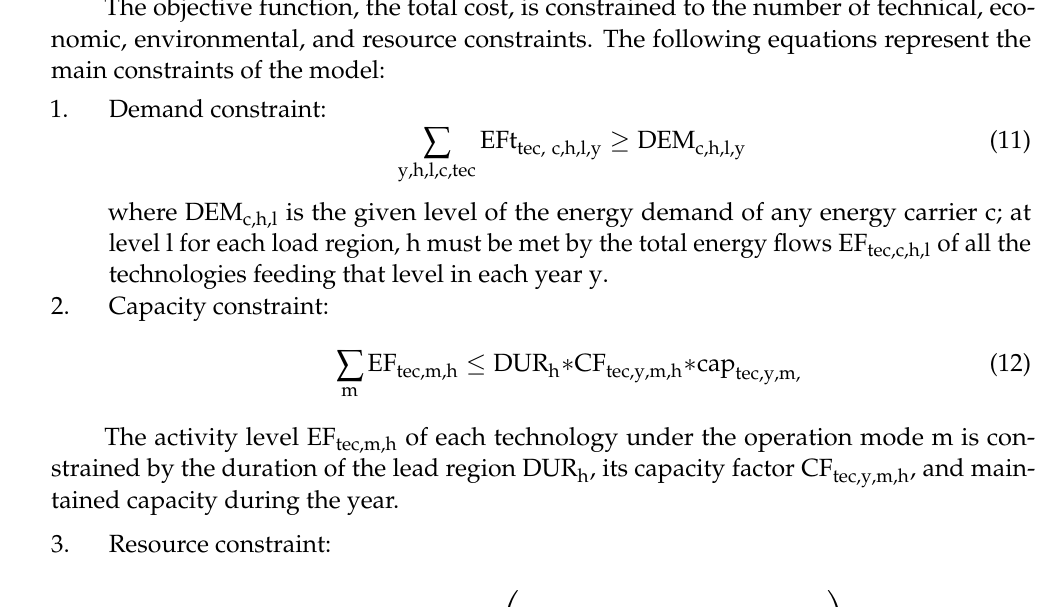
Figure 6. Reference Energy System (RES) for Pakistan .